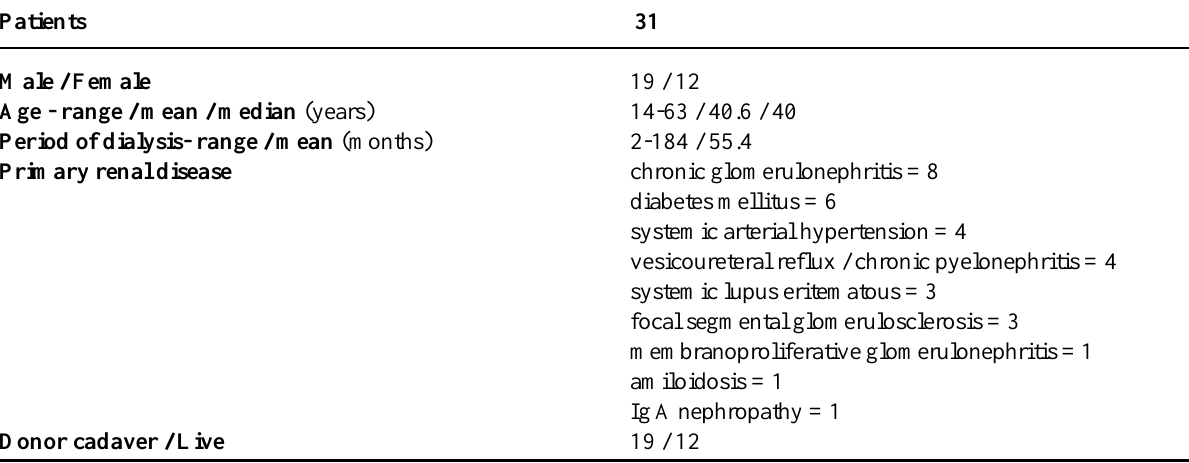
Table 1 – Characteristics of transplanted patients with urinary fistula.